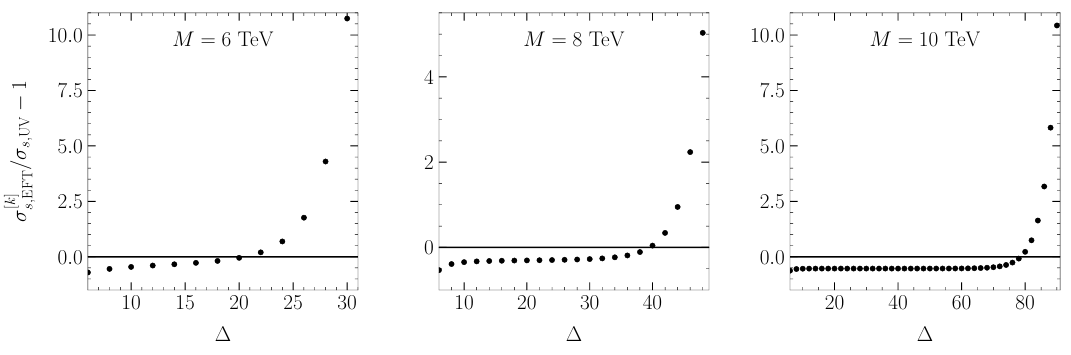
Figure 16 . The relative error (see eq. (5.10)) as computed for the s -channel model in the “Hadronic √ s = 14 TeV and m φ = 1 TeV. For ∆ < ∆ crit , the EFT Initial State” case where Γ → 0 for M < prediction appears to be converging to the wrong